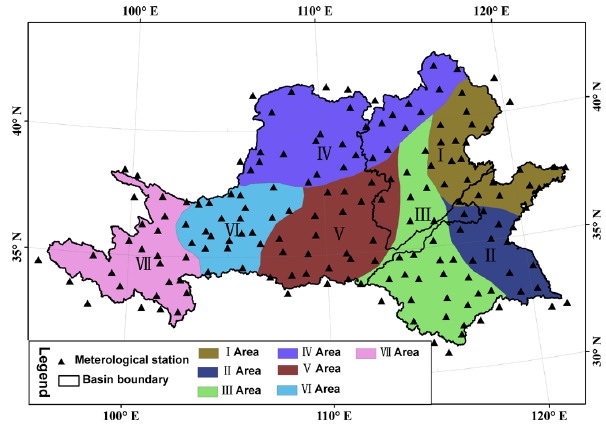
Fig. 3. Subareas of the Huang–Huai–Hai River basin.